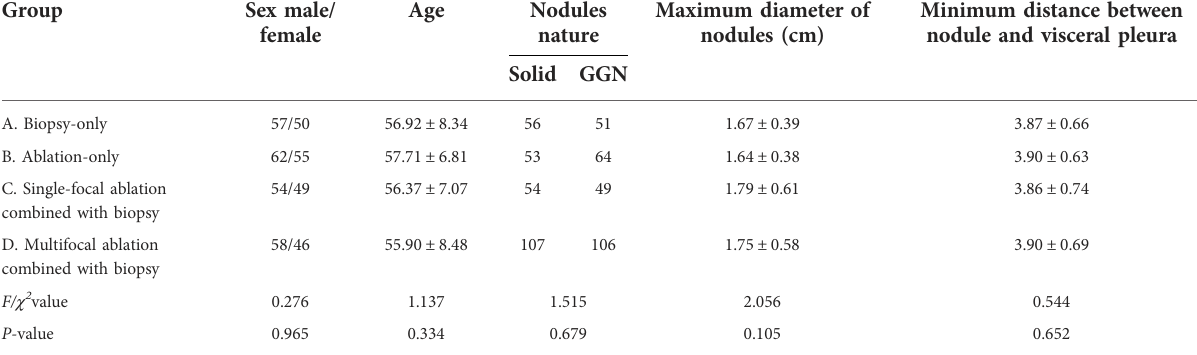
TABLE 1 Basic data of patients undergoing percutaneous thermal ablation and/or biopsy.